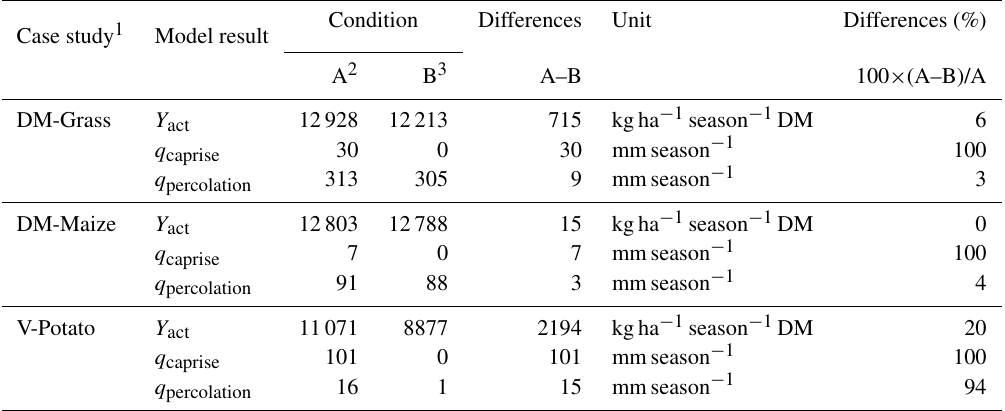
Table 3. Results of the case studies: values and differences in yield, capillary rise and percolation fluxes resulting from simulations with and without capillary rise.